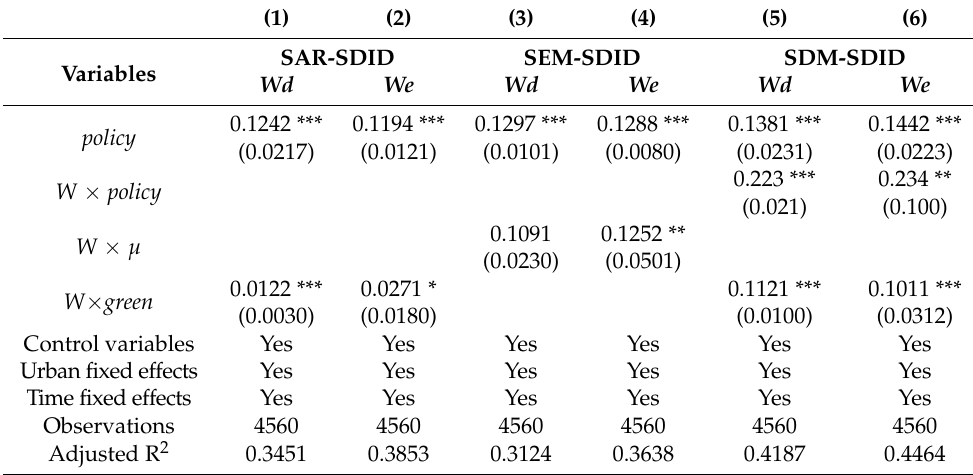
Table 4. Spatial DID model regression